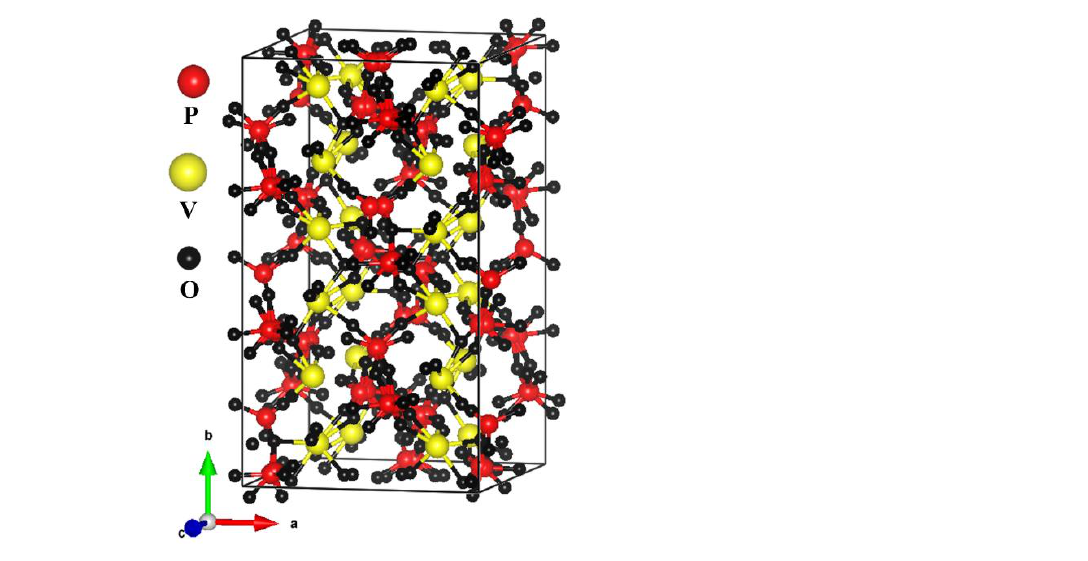
Figure 5. Crystallographic structure of the vanadium(III) tris(metaphosphate) compound. Table 4. V-O bond length in the V(PO 3 ) 3 crystal structure.